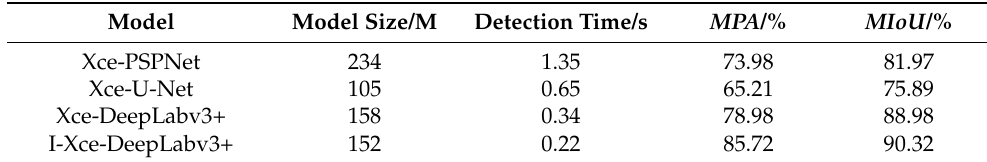
Table 2. Performance of different segmentation